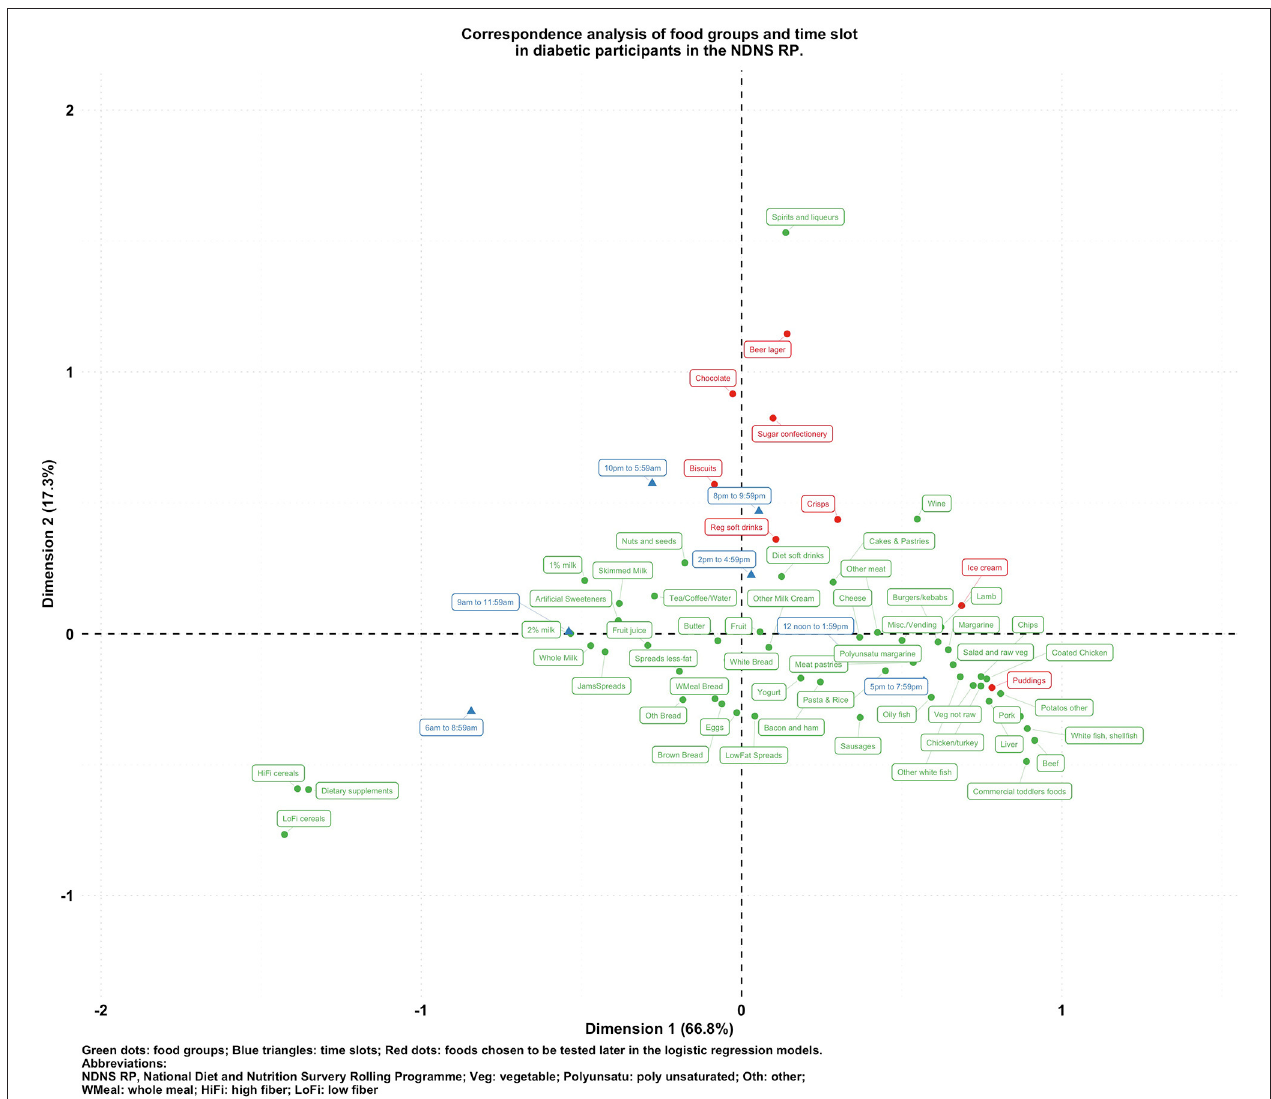
FIGURE 3 | Biplot of food groups and eating time slots in diabetic participants in the NDNS RP.